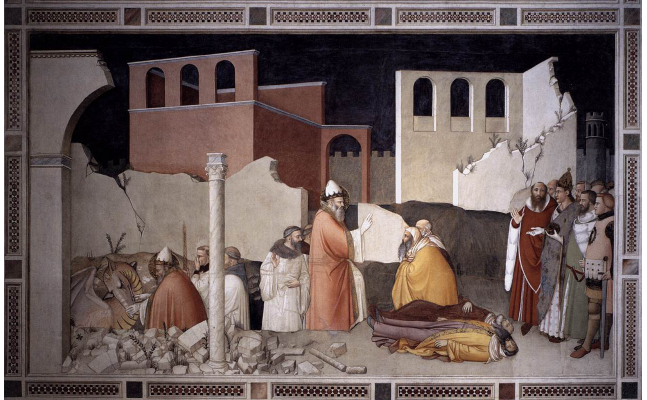
Fig. 3 Maso di Banco, Miracolo di San Silvestro , c.1340 (Firenze, Chiesa di Santa Croce, Cappella Bardi di